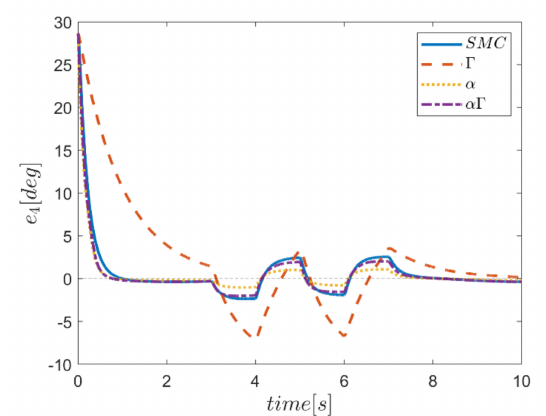
Figure 21. Tracking error in the Φ channel.